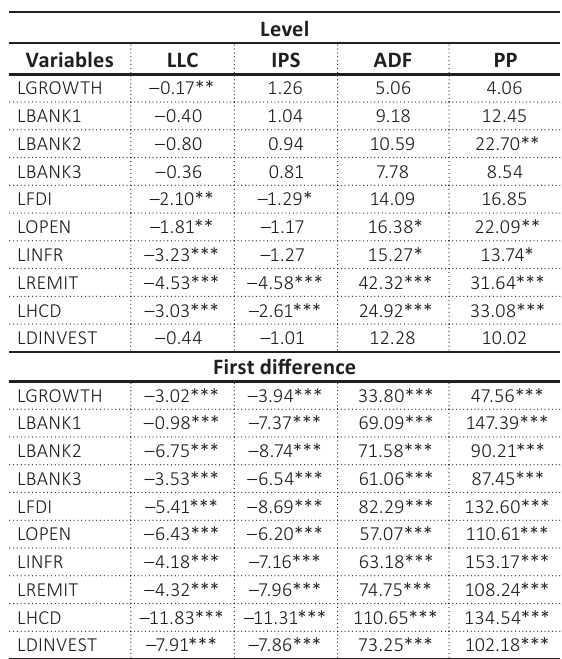
Table 1. Individual intercept – Stationarity tests